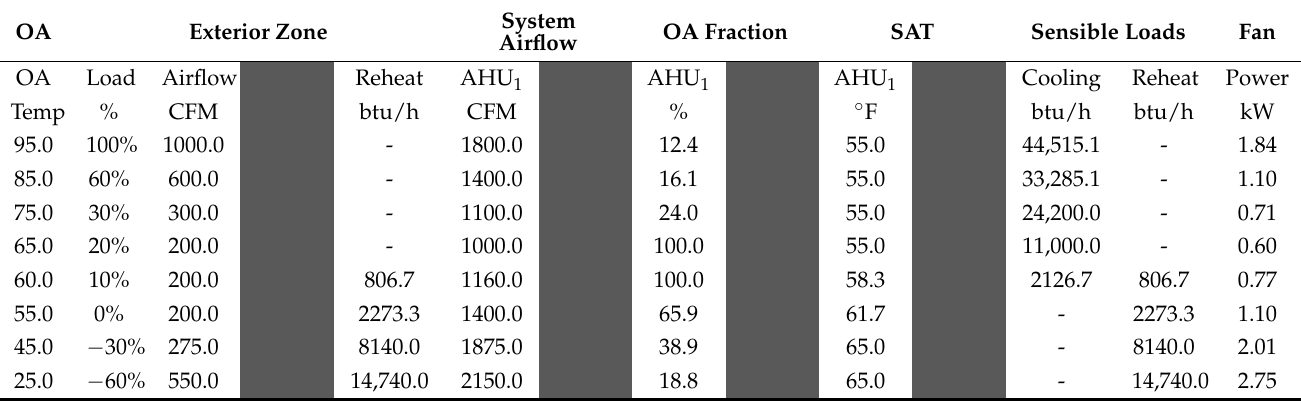
Table 2. Calculations for Single Duct VAV system.